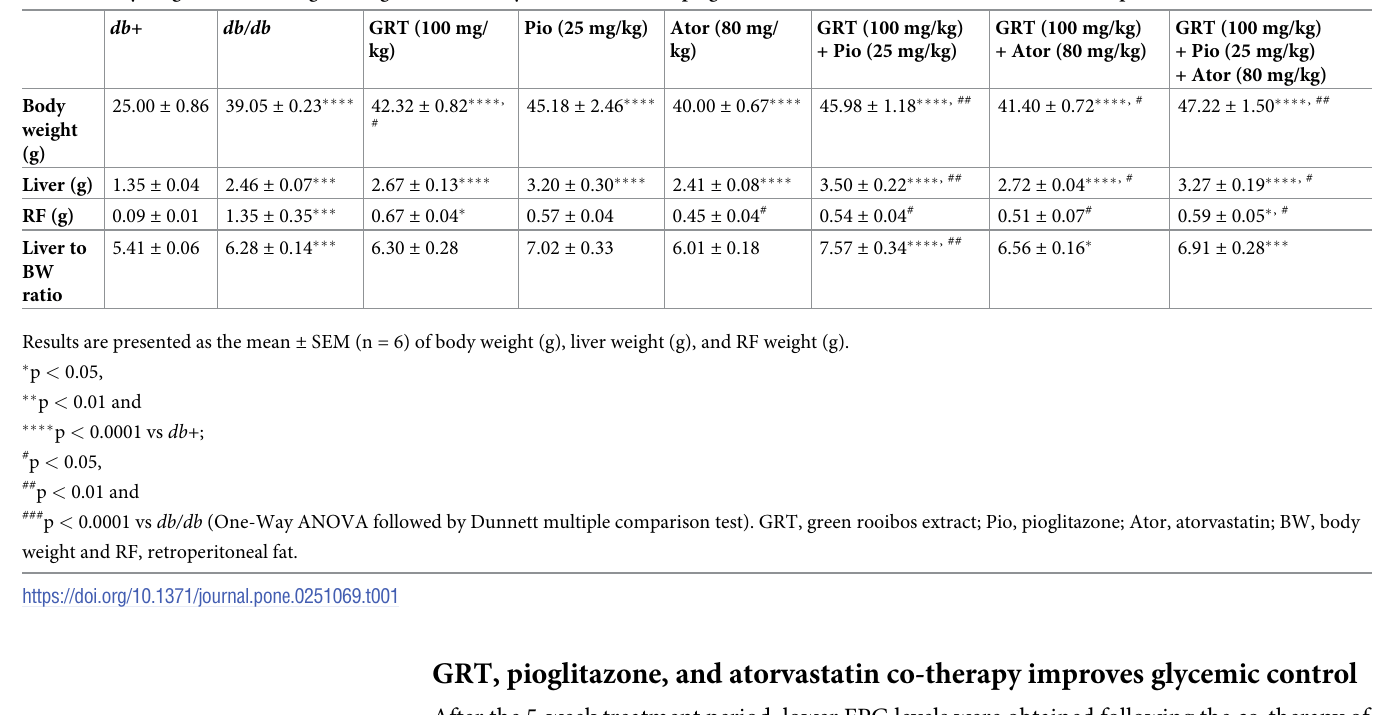
GRT, pioglitazone, and atorvastatin co-therapy improves glycemic control After the 5-week treatment period, lower FPG levels were obtained following the co-therapy of GRT with pioglitazone (from 26.44 ± 1.84 to 15.33 ± 2.39; p = 0.006) and atorvastatin (from 26.44 ± 1.84 to 19.93 ± 1.63; p = 0.03), respectively (Fig 1). The combination of GRT-pioglita- zone-atorvastatin effectively lowered the FPG level compared to the db/db control (from 26.44 ± 1.84 to 15.17 ± 1.96; p = 0.003). In comparison to the combination therapy, GRT, ator- vastatin and pioglitazone monotherapies did not reduce FPG levels. GRT, pioglitazone, and atorvastatin co-therapy reduces TG, cholesterol, and LDL-C levels, and improves hepatic steatosis Combination therapies of GRT and pioglitazone, and GRT, pioglitazone and atorvastatin showed significant increases in body and liver weights (Table 1). However, atorvastatin as well as the combination of GRT with pioglitazone, and GRT with pioglitazone and atorvastatin sig- nificantly reduced RF weights (Table 1). Following treatment, serum cholesterol, TG and LDL-C levels were significantly increased in db/db mice compared to the db+ mice (Fig 2a– 2d). Atorvastatin reduced cholesterol (from 4.00 ± 0.12 to 2.93 ± 0.13; p = 0.00003), TG (from 2.77 ± 0.50 to 1.48 ± 0.23; p = 0.04), and HDL-C (from 2.86 ± 0.05 to 2.27 ± 0.08; p = 0.0003) levels compared to the db/db mice control (Fig 2a–2d). GRT and atorvastatin co-therapy low- ered cholesterol (from 4.00 ± 0.12 to 3.50 ± 0.11; p = 0.02) and HDL-C (from 2.86 ± 0.05 to 2.53 ± 0.05; p = 0.0002) levels (Fig 2a–2d). Similarly, the triple therapy combination of GRT- pioglitazone-atorvastatin decreased serum cholesterol (from 4.00 ± 0.12 to 3.24 ± 0.22; p = 0.02), TG (from 2.77 ± 0.50 to 0.73 ± 0.07; p < 0.0001), and HDL-C (from 2.86 ± 0.05 to 2.44 ± 0.16; p = 0.04) levels. GRT, pioglitazone, and atorvastatin co-therapy reduces hepatic steatosis In comparison to the lean db+ littermates, the db/db mice presented with an increase in micro-, mediovesicular and macrovesicular steatosis (Table 2, Fig 3). Apart from hepatic